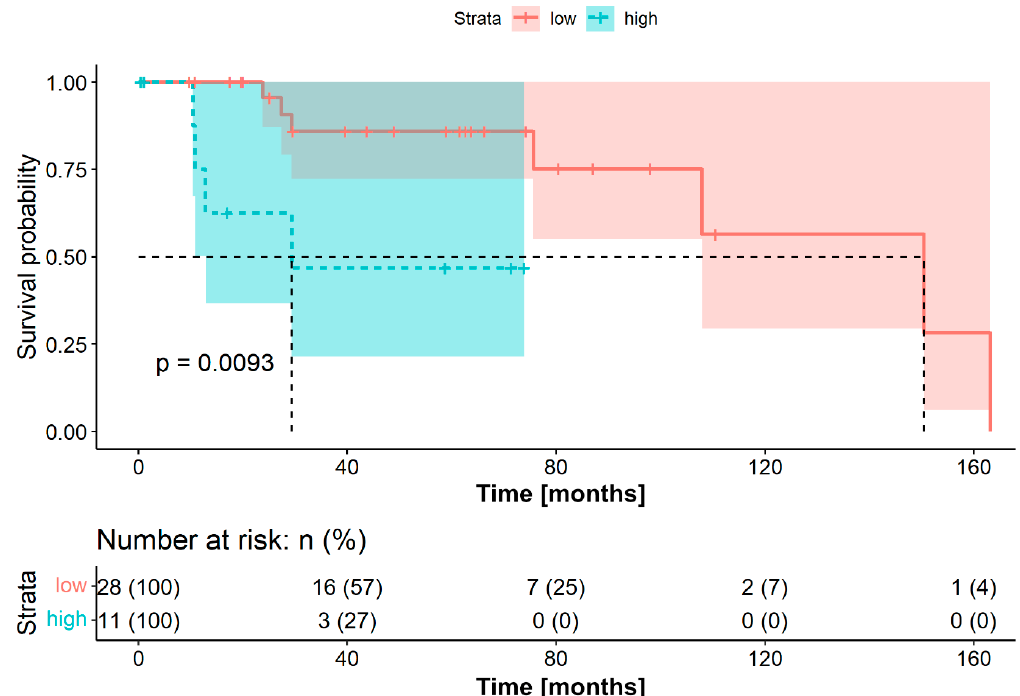
Figure 1. Overall survival for patients with adenoid-cystic carcinoma stratified into a low ( n = 28) and high group ( n = 11) according to the optimal threshold for fibrinogen-to-lymphocyte ratio for overall survival (272.9). The corresponding brighter colored areas represent the 95% confidence intervals. The survival times were statistically significantly different between patients with low and high fibrinogen-to-lymphocyte ratio (log-rank test p = 0.0093).